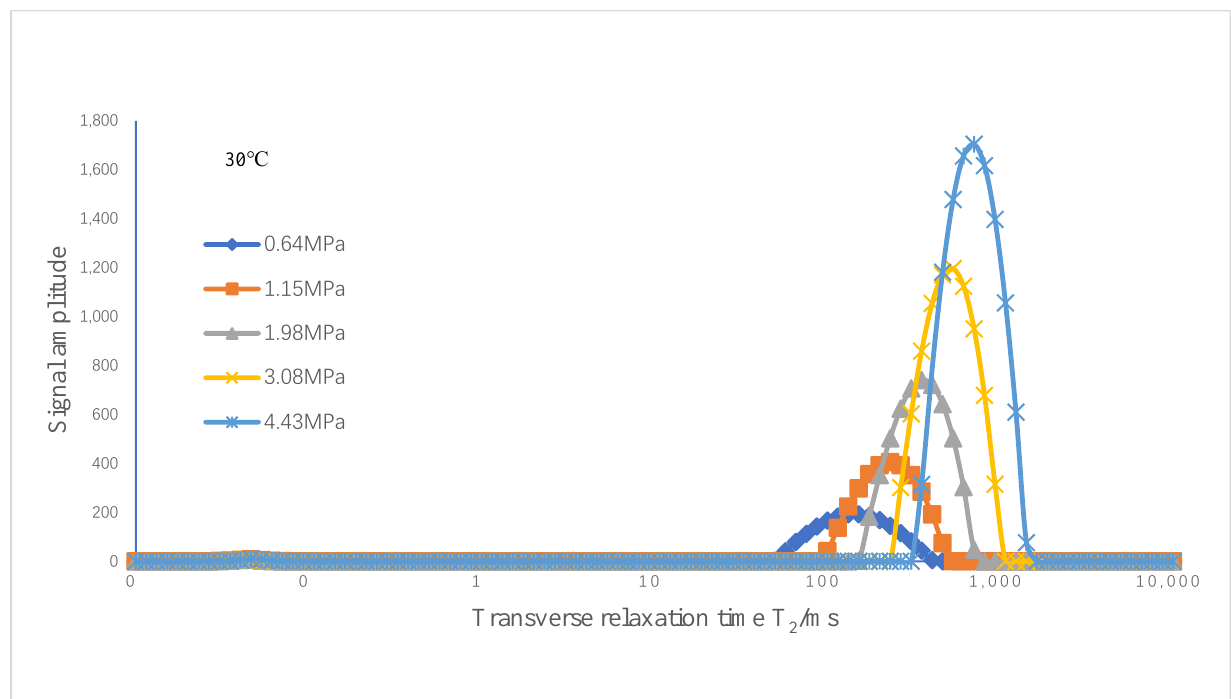
Figure 3. Nuclear magnetic T